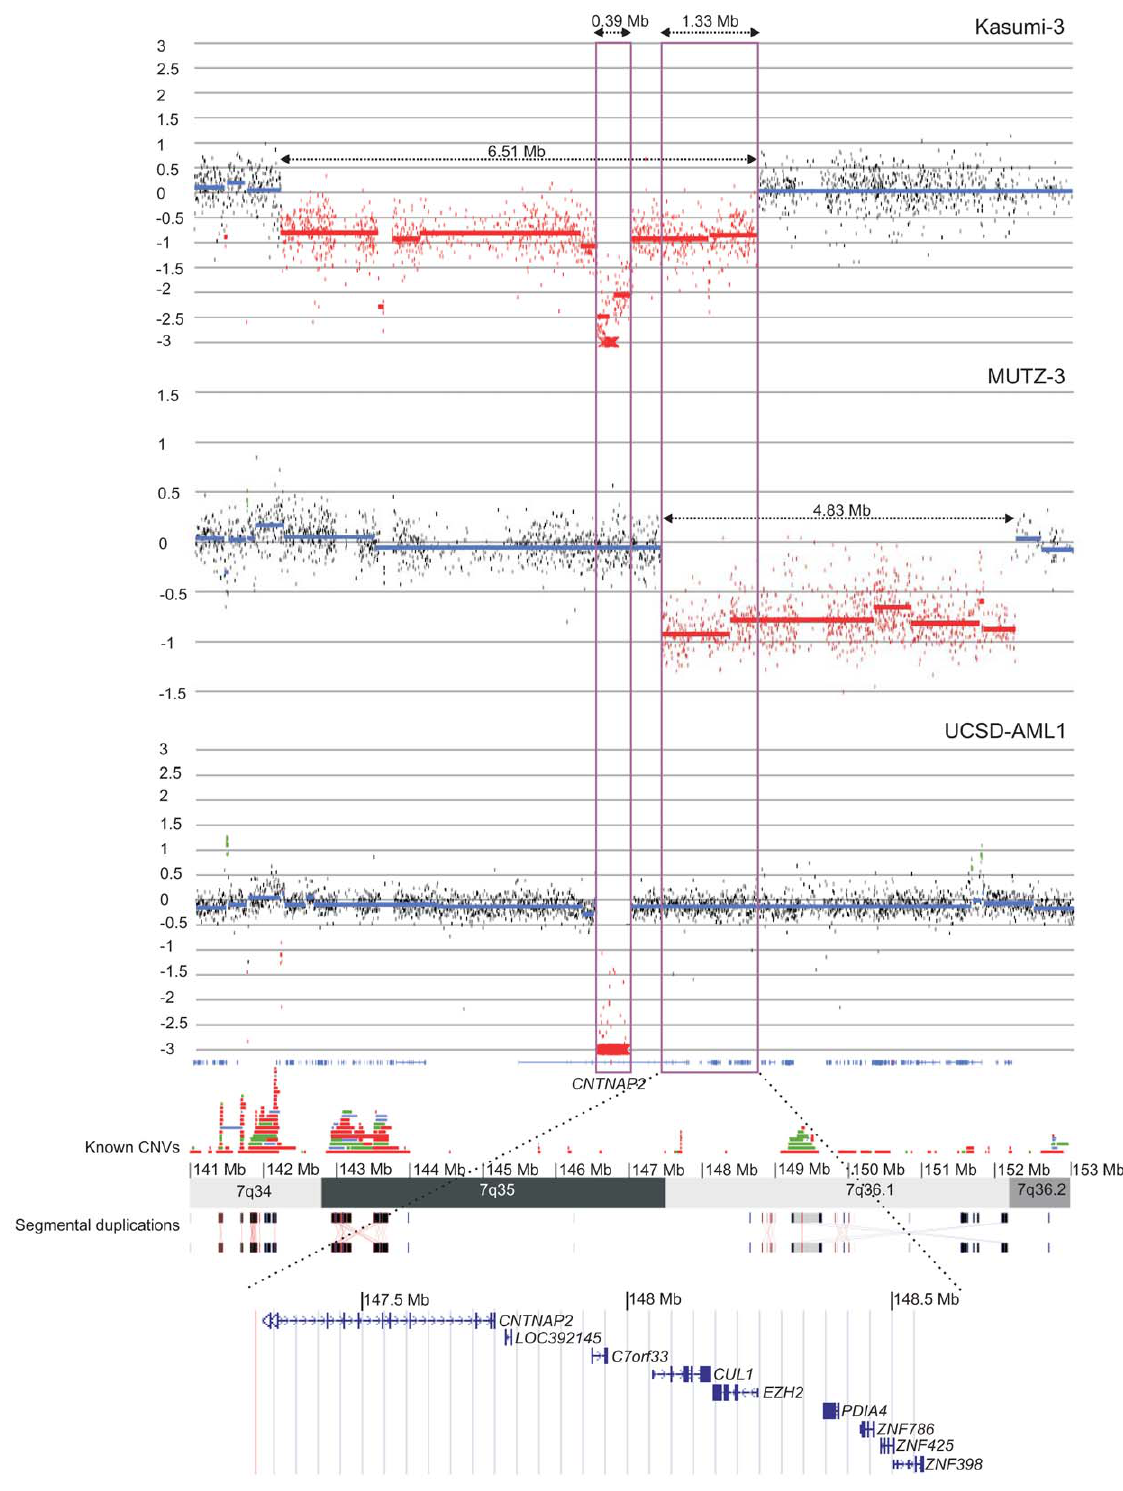
Figure 3. Array CGH profile of chromosome 7 (141 Mb–153 Mb) for Kasumi-3, MUTZ-3 and UCSD-AML1. A) Array CGH profile of Kasumi-3, B) MUTZ-3 and C) UCSD-AML1 indicating the 0.39 Mb SRO on 7q35 and the 1.33 Mb SRO on chromosome bands 7q35–q36. Log 2 -ratios of the clones are depicted by vertical dots corresponding to the respective genomic position (NCBI build 36). Deletions are shown in red. The SROs are indicated with a purple box. The bottom of the figure shows the genomic position with an indication of known CNVs as present in the Database of Genomic Variants (http://projects.tcag.ca/variation/). Regions of segmental duplication are displayed using black and grey boxes indicating identical genomic regions. A screenshot of the UCSC Genome Browser (NCBI build 36, http://genome.ucsc.edu) shows an overview of the known RefSeq genes in the 1.33 Mb critical region.